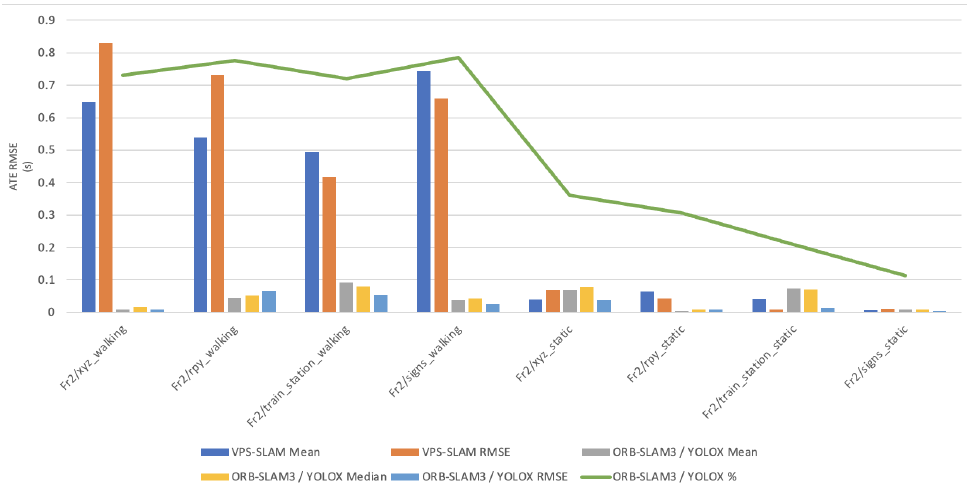
Figure 12. Absolute Trajectory Error (RMSE) distribution of VPS-SLAM and ORB-SLAM3/YOLOR.